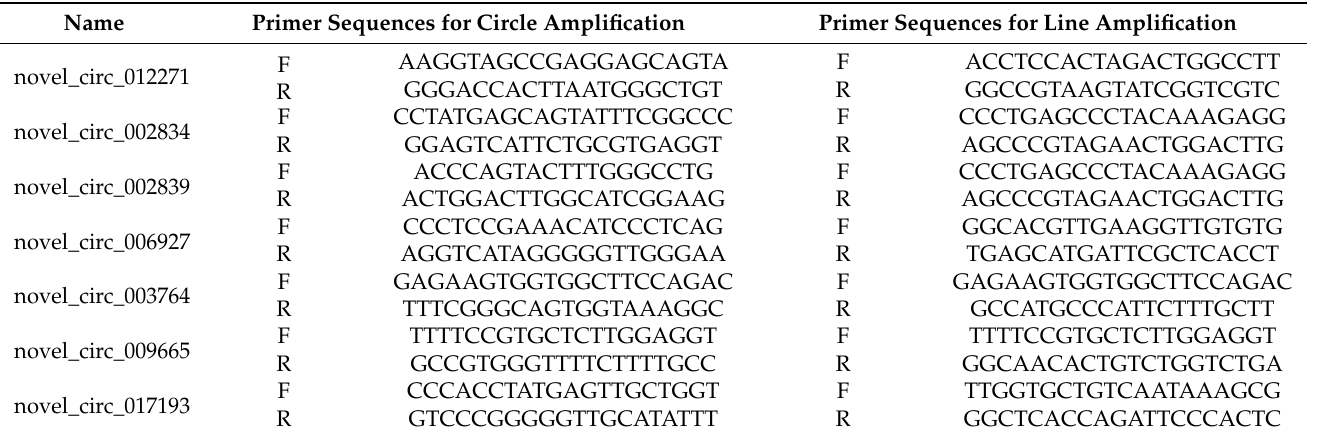
Table 1. Primer sequences of DEcircRNAs for